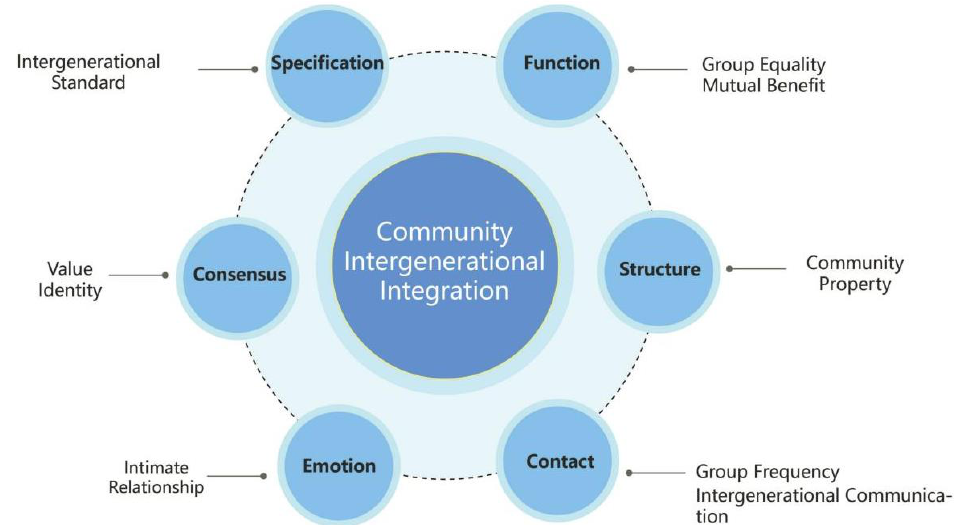
theory in a community context.